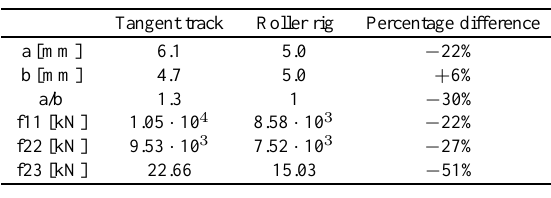
Table 2 Discrepancies between the contact coefficients involved in the linear theory. In addition, the bogie mass is taken into account